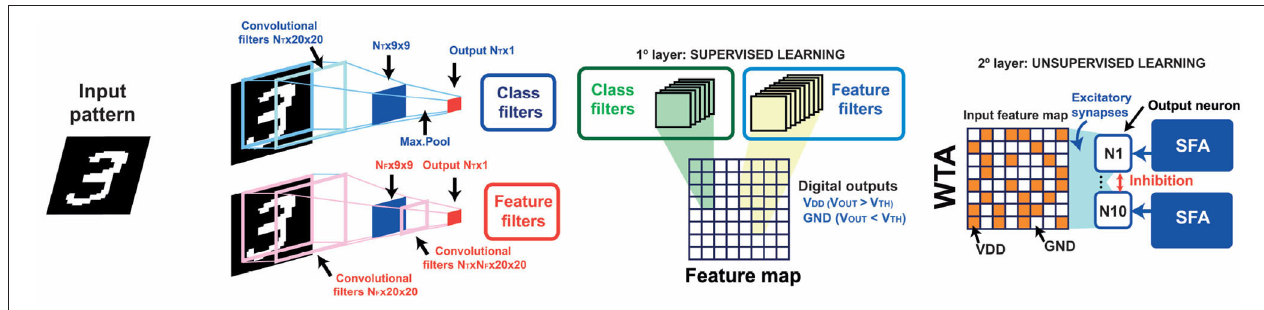
FIGURE 11 | Schematic architecture of the hybrid supervised-unsupervised neural network. The input patterns coming from the dataset are convolved with pre-trained convolutional filters. Each filter, which can recognize a generic feature, “feature-filter,” or a specific class, “class filter,” gives a single-bit response (found/not